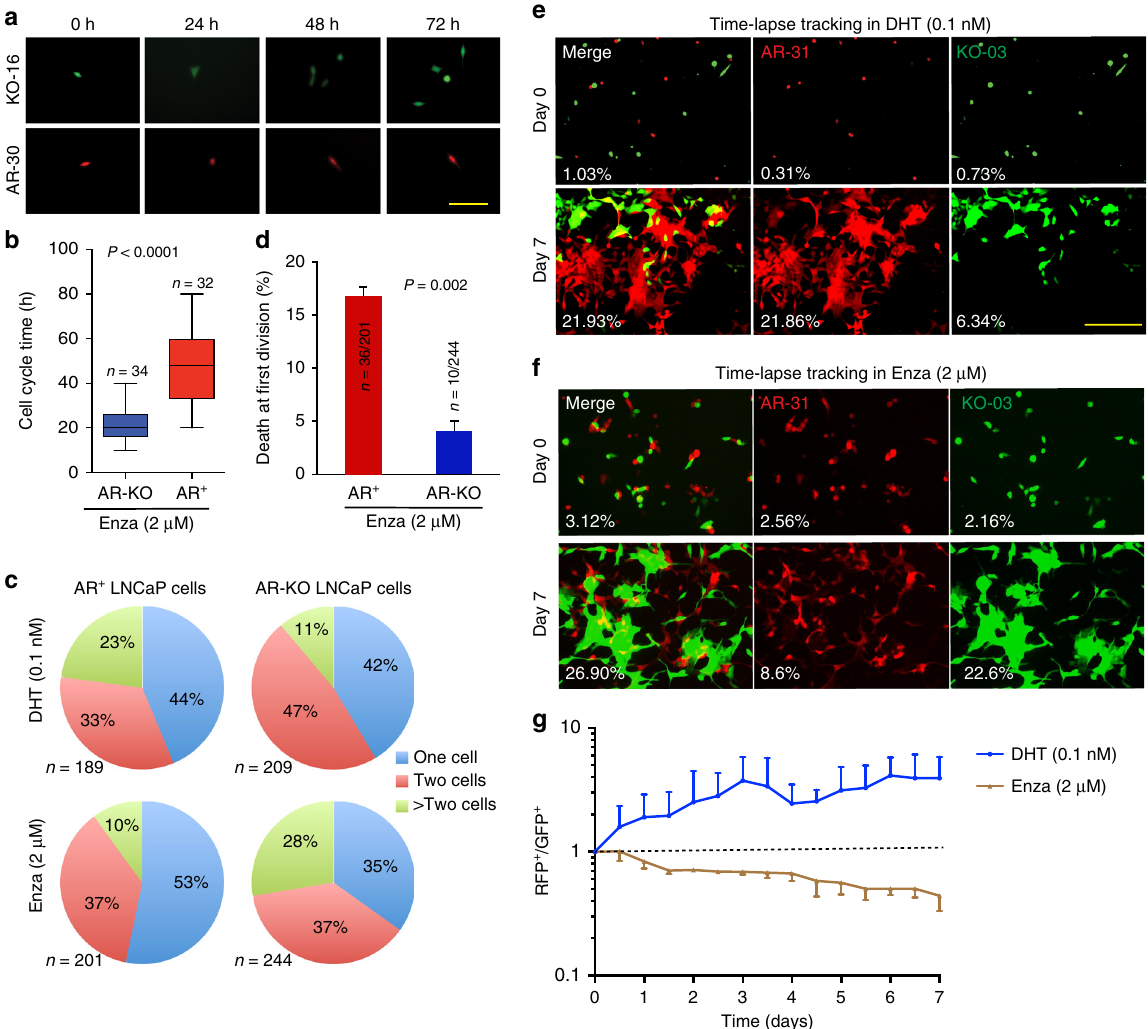
Fig. 6 Unique biological properties and competitive advantages of AR-KO LNCaP cells in Enza-containing media. a Single AR-KO LNCaP cells divide faster and have shorter cell-cycle transit times than AR + LNCaP cells in the presence of Enza as determined by time-lapse videomicroscopy. Representative images of a KO-16 cell (labeled with GFP, upper), which divided several times within 72 h and an AR-30 cell (lower), which did not divide within the same time interval. Scale bar: 250 μ m. Corresponding movies were shown in Supplementary movies 1 and 2. b Graphical presentation of cell-cycle transition times in AR-KO vs. AR + LNCaP cells based on the time-lapse tracking of the 2 AR + (AR-30 and AR-31) and 2 AR-KO (KO-03 and KO-16) LNCaP clones. The total number of cells analyzed and P value (Student ’ s t -test; mean ± SD) are indicated. Scale bar: 250 μ m. c Single AR-KO LNCaP cells undergo more cell divisions than AR + clonal LNCaP cells in the presence of Enza (2 μ M). Single AR + (AR-30 and AR-31) and AR-KO (KO-03 and KO-16) cells in either DHT-containing (top) or Enza-containing (bottom) media were put under the JuLi Stage time-lapse videomicroscope and tracked for 4-5 continuous days with images taken every 2h. Shown are pie chart presentations of endpoint clones that contained 1 cell, 2 cells, or >2 cells (3 – 6 cells) in each clone. Clones that contained >2 cells indicate that the starting single cell divided more than once during the recording period. The total number of single cells analyzed is indicated below ( n ). See Text for details. d High propensity of AR + LNCaP cells undergoing death at the fi rst cell division in the presence of Enza. As indicated, ~18% (36/201) of single AR + LNCaP cells, compared to 4% (10/244) single AR-KO cells, were dead ( P = 0.002, Student ’ s t -test, mean ± SD) during the fi rst cell division when cultured in Enza. e , f Competitive advantage of AR + cells in DHT-containing media and of AR-KO cells in Enza-containing media. RFP + AR-31 LNCaP cells were mixed (1:1) with GFP-labeled KO-03 cells and plated in either DHT-containing ( a ) or Enza-containing ( b ) media at clonal density on day 0 and then tracked for 7 days. Shown are representative images. The percentages refer to relative con fl uence ( fl uorescence-positive area divided by the total area) determined by the JuLi Stage fl uorescence time-lapse microscope. g Graphical presentation of competitive advantages of AR + and AR-KO LNCaP cells in DHT-containing and Enza-containing media, respectively. Shown is the ratio of RFP + (AR + ) over GFP + (AR-KO) LNCaP cells BCL-2 as a therapeutic target in AR + /hi 2° LNCaP CRPC . (Supplementary Fig. 14a), normal human prostate basal/stem cells 25 (Supplementary Fig. 14b), and patient CRPC-NE 24 (Fig. 7c, Interestingly, BCL-2 is prominently upregulated at both mRNA (Fig. 7d, Supplementary Fig. 12b, e; Supplementary Fig. 15a) and Supplementary Fig. 14c). Annotation of the 601 genes preferen- protein (Fig. 2b, Supplementary Fig. 11a, 15b) levels in 1° and, in tially expressed in 2° LNCaP CRPC involved speci fi cally in Enza particular, 2° LNCaP CRPC. BCL-2 ‘ target genes ’ are also enri- resistance reveals further enrichment in genes associated ched in 2° LNCaP CRPC (Fig. 7e). Signi fi cantly, BCL-2, but not with stem cell and lipid signaling (Fig. 7d, Supplementary BCL-XL or MCL-1, is selectively upregulated in clinical CRPC 22 Fig. 14d – h). NATURE COMMUNICATIONS| (2018) 9:3600 |DOI: